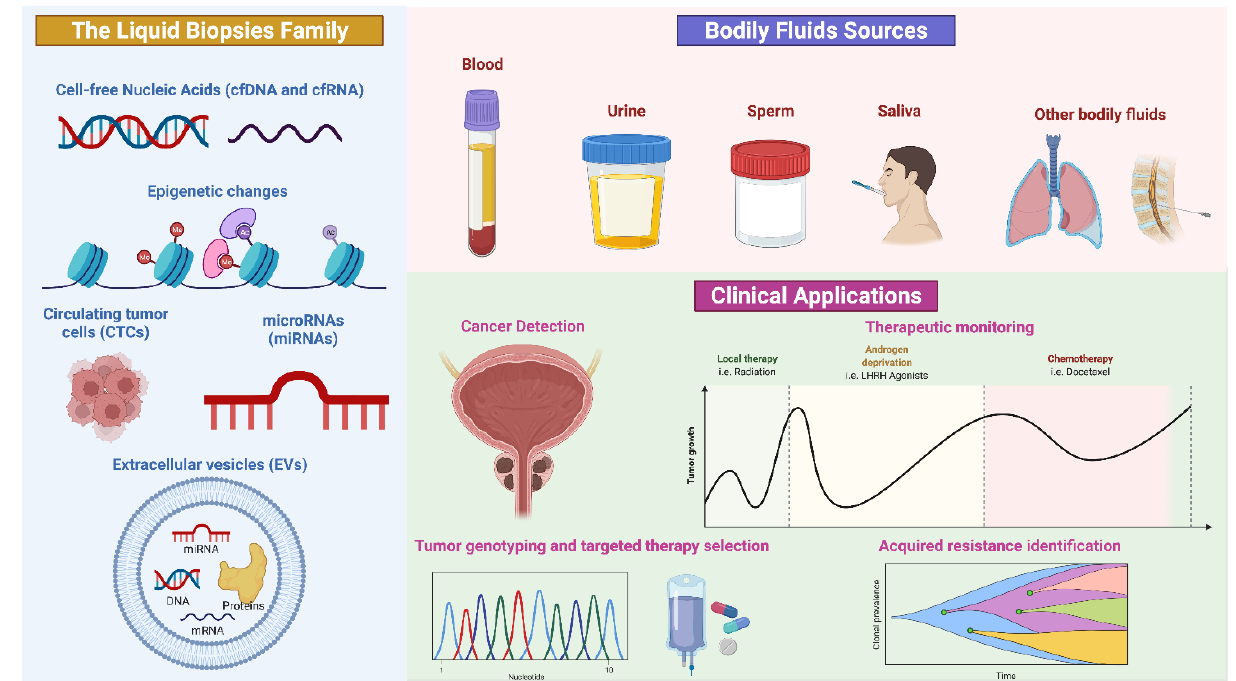
Figure 1. Schematic representation of liquid biopsy composition and application. Credit: Created with BioRender.com (accessed on 3 June 2022).